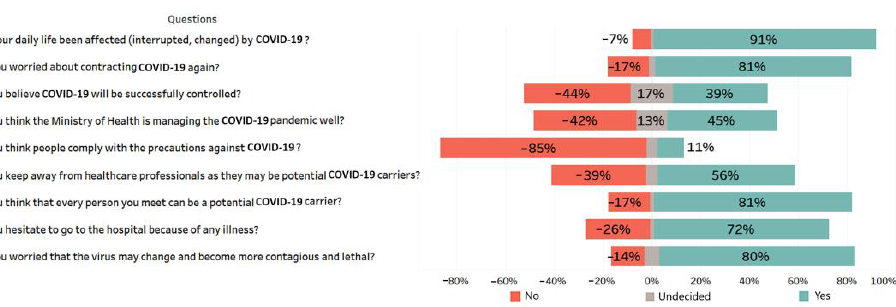
Figure 3. Attitudes of the participants toward COVID-19 ( n = 664).